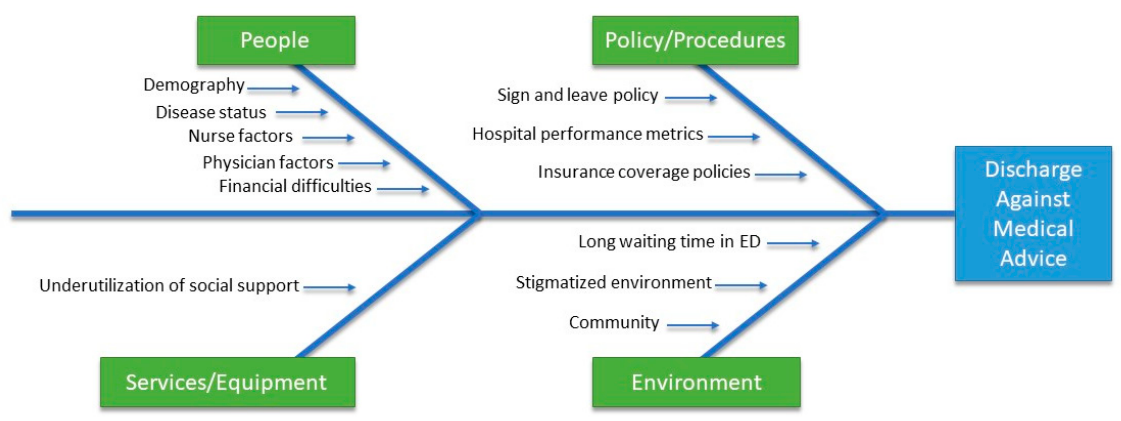
Figure 2. A fishbone diagram showing the causes and categories for discharges against medical advice.